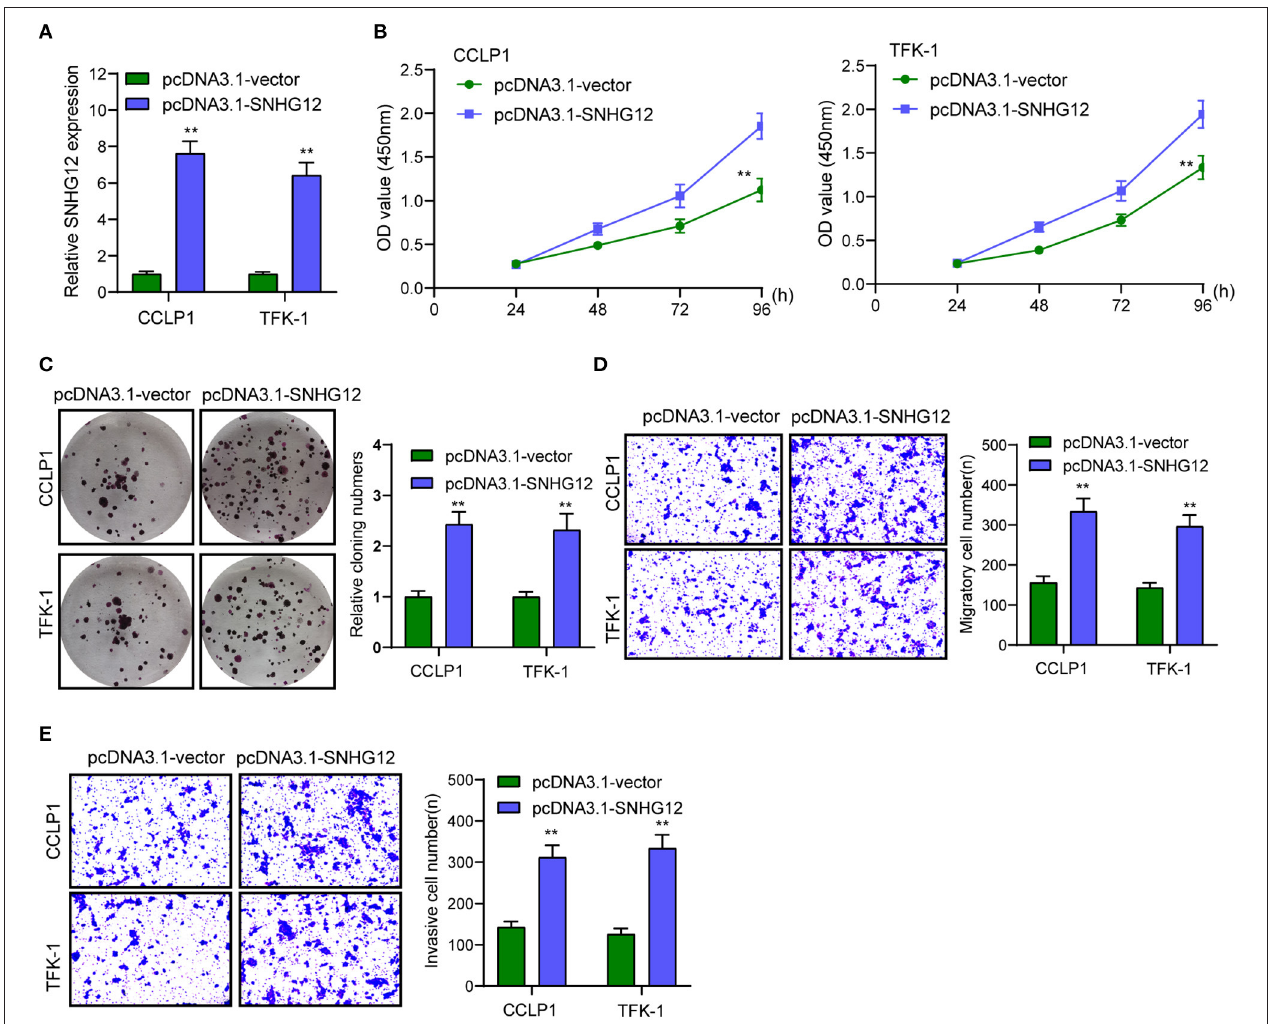
FIGURE 2 | Overexpression of SNHG12 promoted the proliferation and metastasis of TFK-1 and CCLP1 cells. (A) RT-PCR assay was used to detect SNHG12 level in SNHG12 overexpression plasmids transfected TFK-1 and CCLP1 cells. (B,C) Overexpression of SNHG12 distinctly promoted the proliferation of TFK-1 and CCLP1 cells. (D,E) Transwell assay indicated the migrated and invaded cell number in TFK-1 and CCLP1 cells cells. ** p <